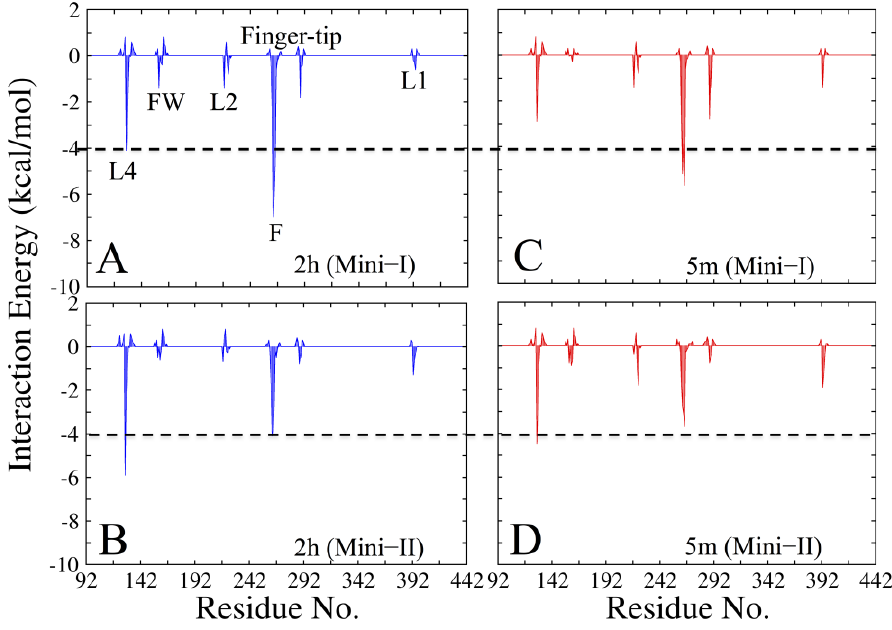
Figure 5. The interaction energy of ( A , B ) 2h and ( C , D ) 5m in mini-1 and mini-2, respectively.